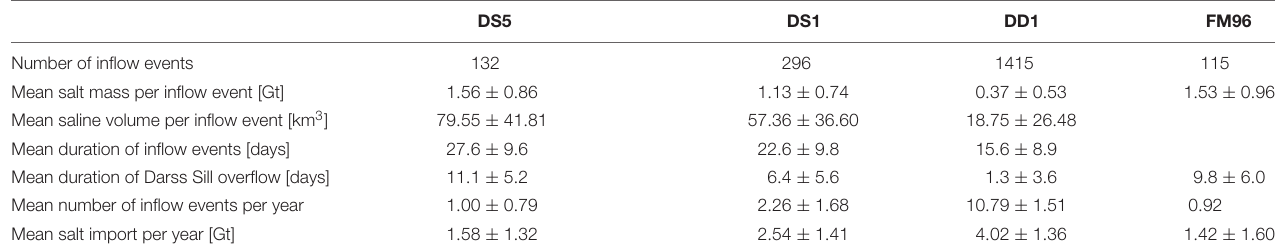
TABLE 1 | Number of barotropic inflow events and averaged properties for the inflow subsets DS5, DS1, DD1, and the FM96 inflow sequence for the period 1887–2017. DS5 DS1 DD1